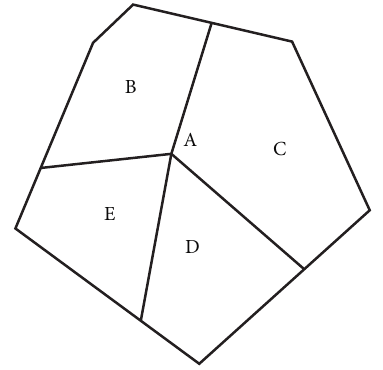
Figure 1: Diagram of airspace sector structure.